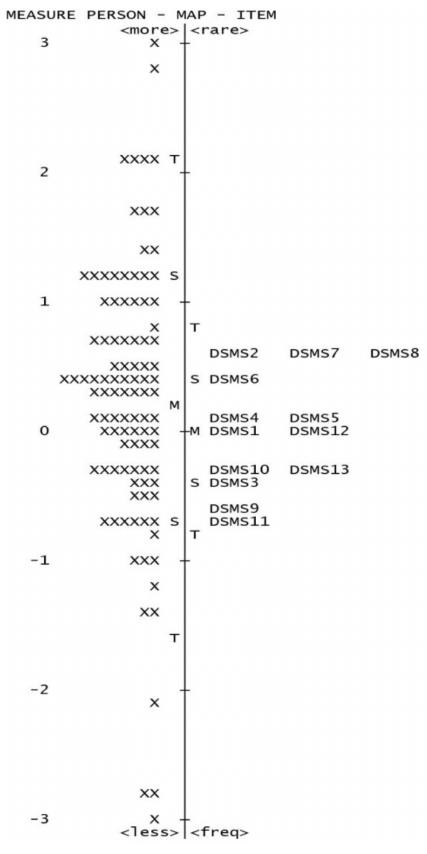
Figure 1. Item map.